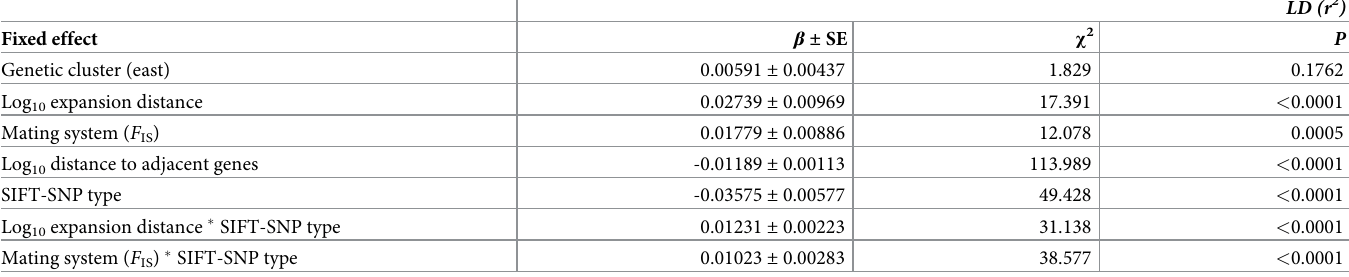
Table 2. Results of the linear mixed-effects model on genome-wide linkage disequilibrium (LD) using only distance-corrected r 2 between pairs of SNPs in genic regions that were annotated by SIFT. For each fixed effect, the model estimate ( β ), as well as the chi-square statistics ( χ 2 ) with the associated p value from a type III Wald χ 2 tests are given. Only results for fixed effects are